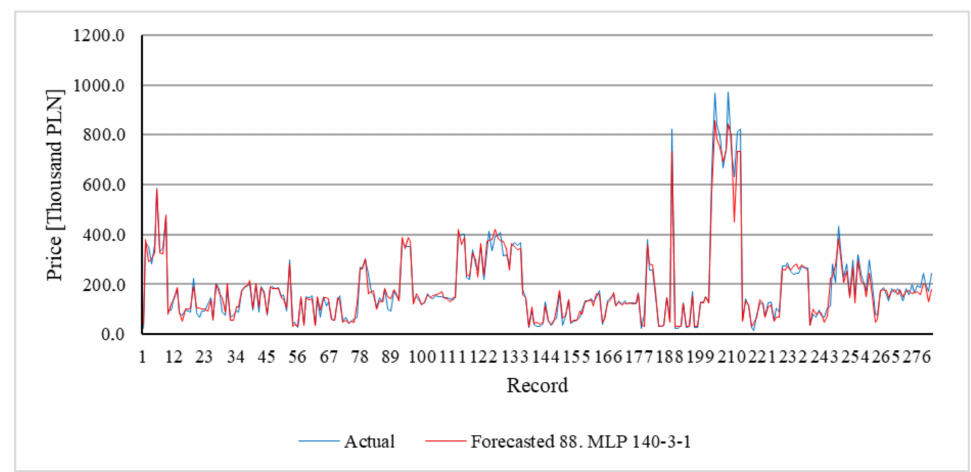
Figure 9. Prediction results for the test set for the Id 88 network (MLP 140-3-1).